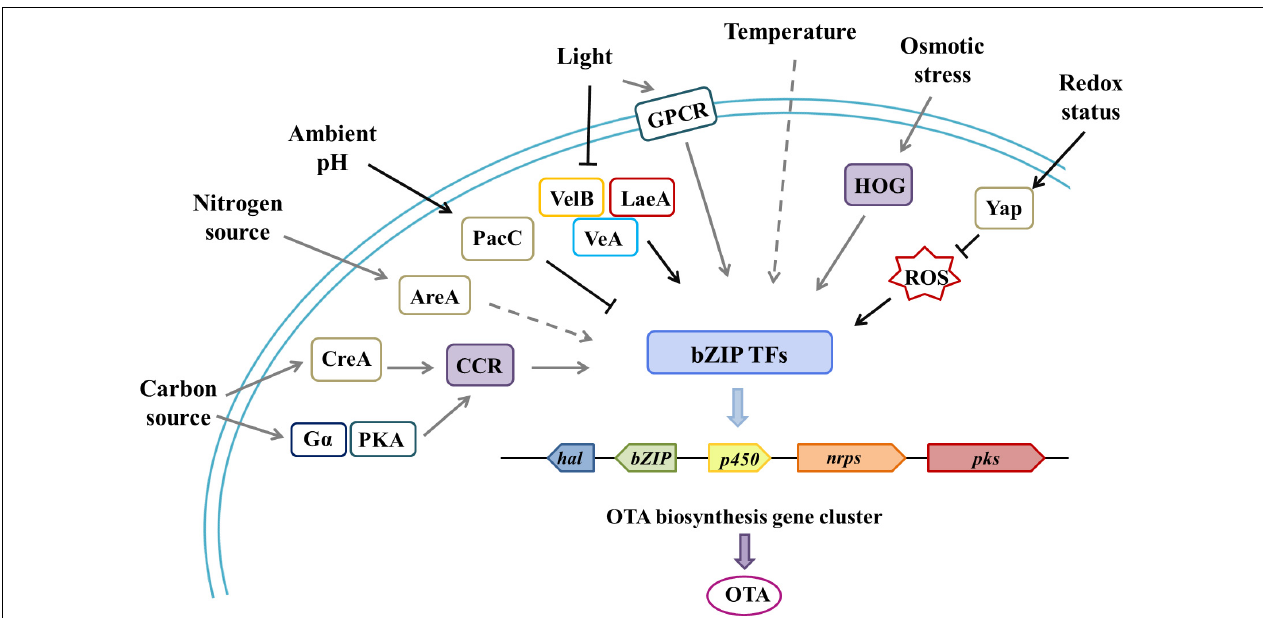
FIGURE 2 | Environmental factors and associated regulatory elements that affect OTA biosynthesis through cluster-specific transcription factors.| Through various global transcription factors or specific pathways, related environmental cues affect the regulation of OTA gene clusters, which contain four highly conserved biosynthetic genes ( pks, nrps, hal/chl, p450 ) and a cluster-specific, transcription factor gene ( bZIP ). bZIP plays a pivotal role in processing various environmental signals for a carbon source (CreA transcription factor and the carbon catabolite repression pathway), a nitrogen source (AreA transcription factor and the nitrogen catabolite repression pathway), light (Velvet complex proteins, VelB-VeA-LaeA, and the global regulator VosA), temperature and humidity, redox status (Yap transcription factor and ROS), and osmotic stress (the high osmolarity glycerol system). At the same time, there are also some examples where G protein pathways are partly involved in the perception of environmental cues, such as G α (GanB) and PKA (PkaA) in A. nidulans and GPCR (NopA) in A. fumigatus . In this figure, the black solid arrows indicate connections verified in OTA-producing fungi; the gray solid arrows indicate connections that have been verified in other toxin-producting fungi, but not verified in OTA-producting fungi; and the gray dashed arrows indicate possible, yet unproven,